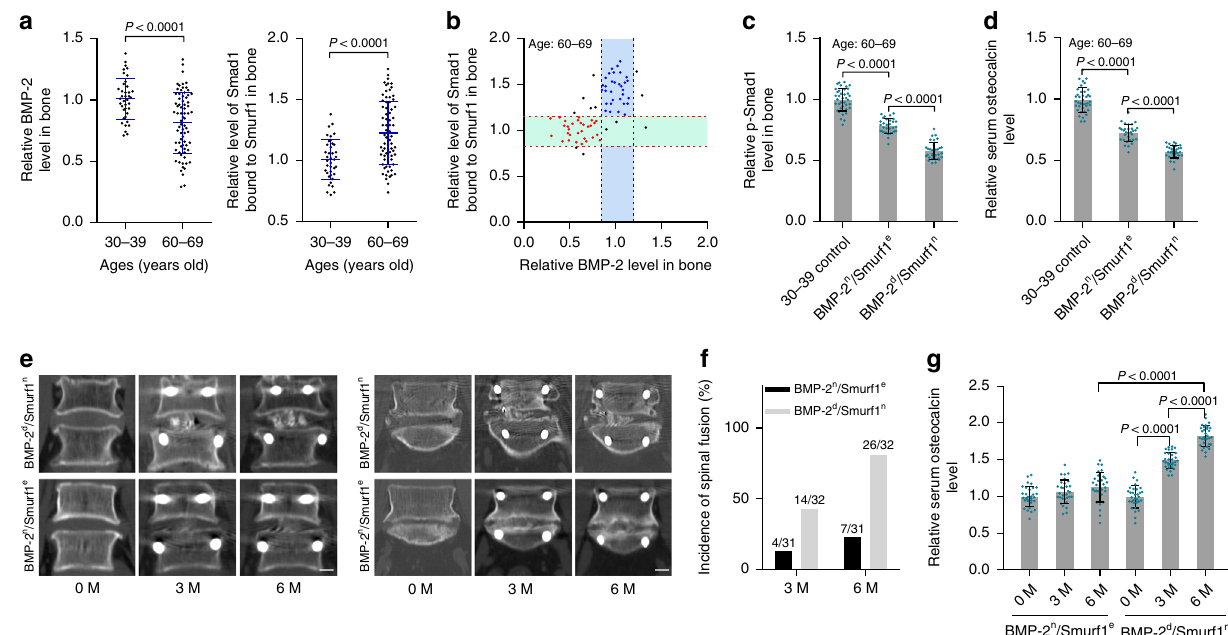
Fig. 2 Local rhBMP-2 response in human BMP-2 n /Smurf1 e and BMP-2 d /Smurf1 n subgroups. a Relative levels of intraosseous BMP-2 (left) and Smurf1 activity (Smad1 bound to Smurf1, right) in osteoporotic LSS patients aged 60 – 69 years old ( n = 74). b Classi fi cation of osteoporotic LSS patients into subgroups based on intraosseous BMP-2 levels and Smurf1 activity (Smad1 bound to Smurf1). The cluster of blue dots, BMP-2 n /Smurf1 e subgroup; the cluster of red dots, BMP-2 d /Smurf1 n subgroup. Relative levels of intraosseous BMP-2 (mean ± s.d., indicated by the two blue dashed lines) and Smad1 bound to Smurf1 (mean ± s.d., indicated by the two red dashed lines) in adult LDH patients (30 – 39 years old) served as cutoff parameters. c Relative level of intraosseous p-Smad1 in BMP-2 n /Smurf1 e subgroup ( n = 31) and BMP-2 d /Smurf1 n subgroup ( n = 32). d Relative level of serum osteocalcin in the above two subgroups. e CT scan showing representative images of spinal fusion in L4-L5 vertebrae (left) or L5-S1 vertebrae (right) in the above two subgroups after local administration of rhBMP-2. Scale bar = 1.0 cm. f Incidence of spinal fusion during rhBMP-2 treatment in the above two subgroups, followed by chi-squared test ( P = 0.007 and P < 0.0001 for BMP-2 d /Smurf1 n versus BMP-2 n /Smurf1 e at 3 M and 6 M, respectively). g Relative serum osteocalcin level during rhBMP-2 treatment in the above two subgroups. Prior to rhBMP-2 treatment, the levels of BMP-2, p-Smad1, osteocalcin and Smad1 bound to Smurf1 were normalized to the mean values of adult LDH patients (30 – 39 years old) ( n = 39). After the rhBMP-2 treatment for 3 months (3 M) or 6 months (6 M), the levels of osteocalcin in the above two subgroups were normalized to their respective baseline at 0 month (0 M). Data are mean ±